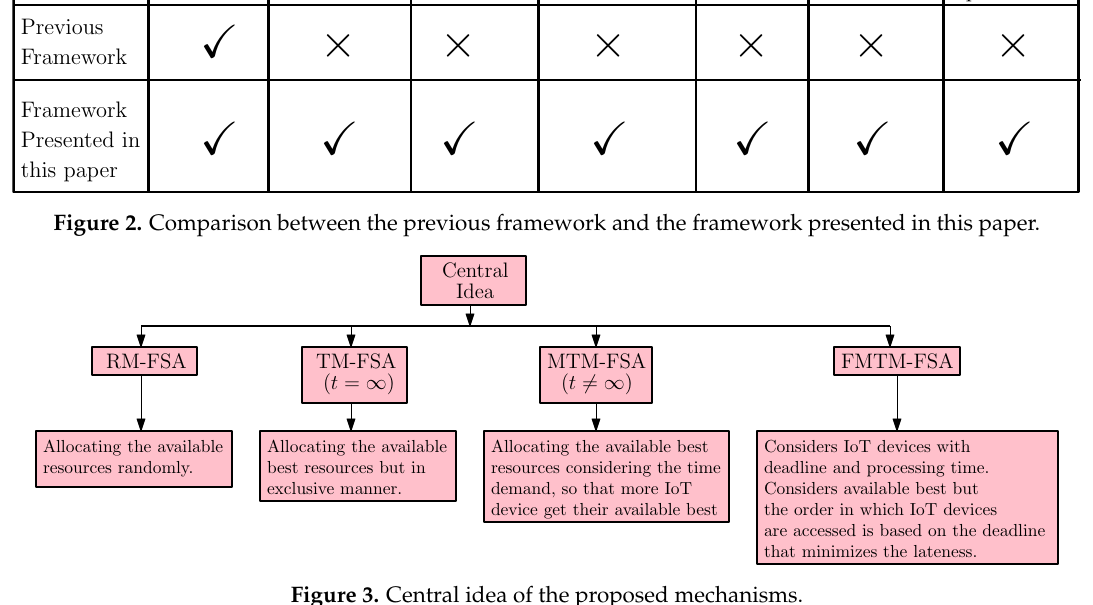
Figure 3. Central idea of the proposed